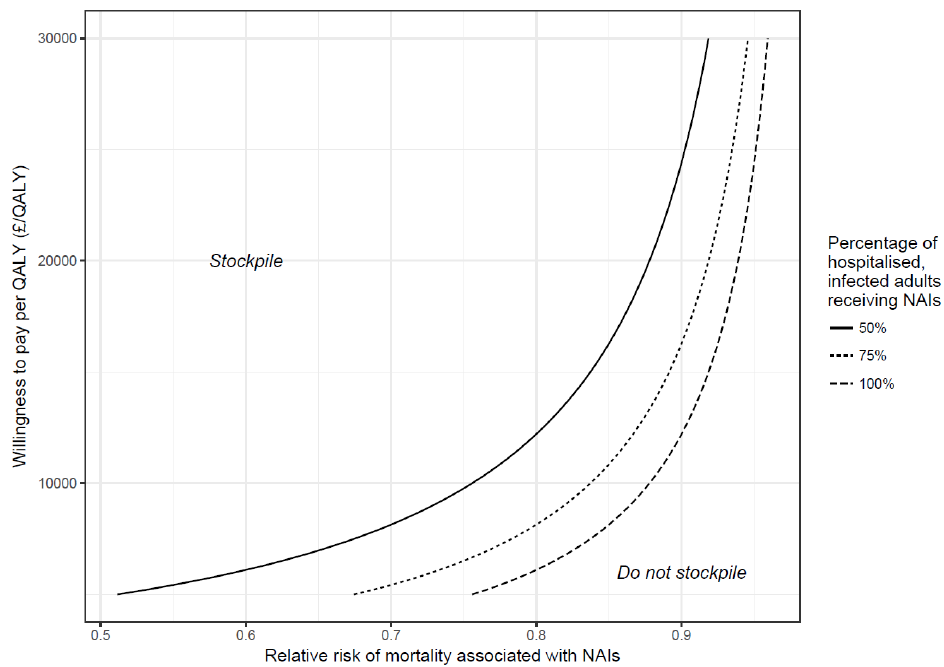
Figure 3. Stockpiling decisions that would be made under a range of different values for the effectiveness of NAIs, the percentage of hospitalised, symptomatic adults that would receive NAIs, and thresholds for willingness to pay per QALY. The lines represent thresholds for decision makers. For any point inside the region bounded by a given line the decision maker should stockpile and conversely any point outside that region the decision maker should not